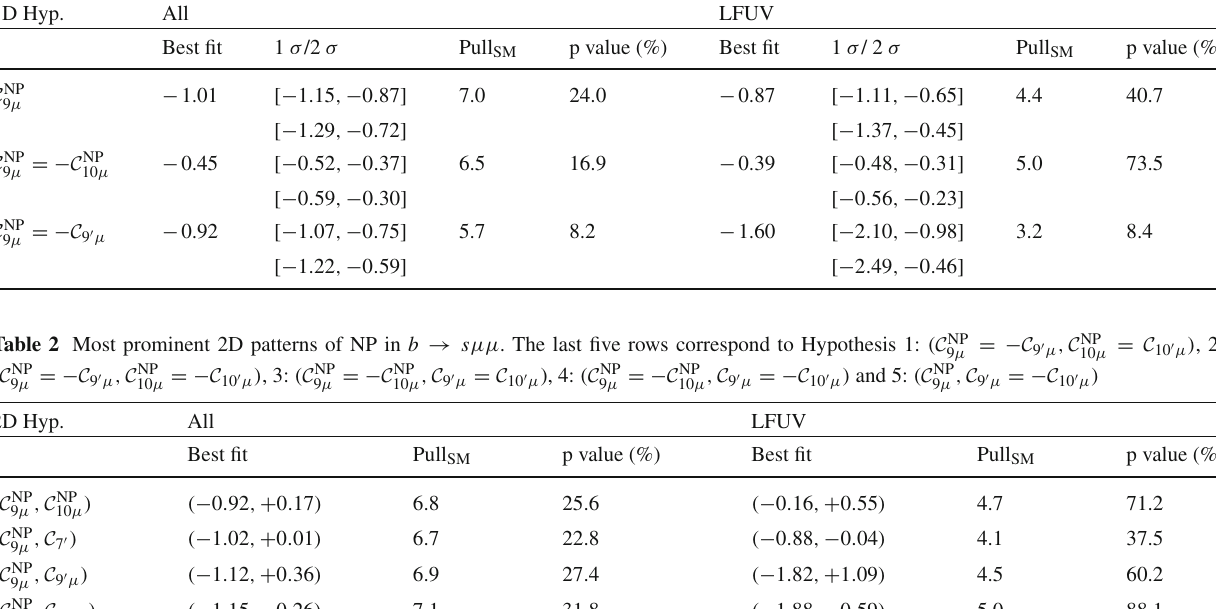
Table 1 Most prominent 1D patterns of NP in b → s μμ . Pull SM is quoted in units of standard deviation. The p -value of the SM hypothesis is 0 . 44% for the fit “All” and 0 . 91% for the fit LFUV 1D Hyp.